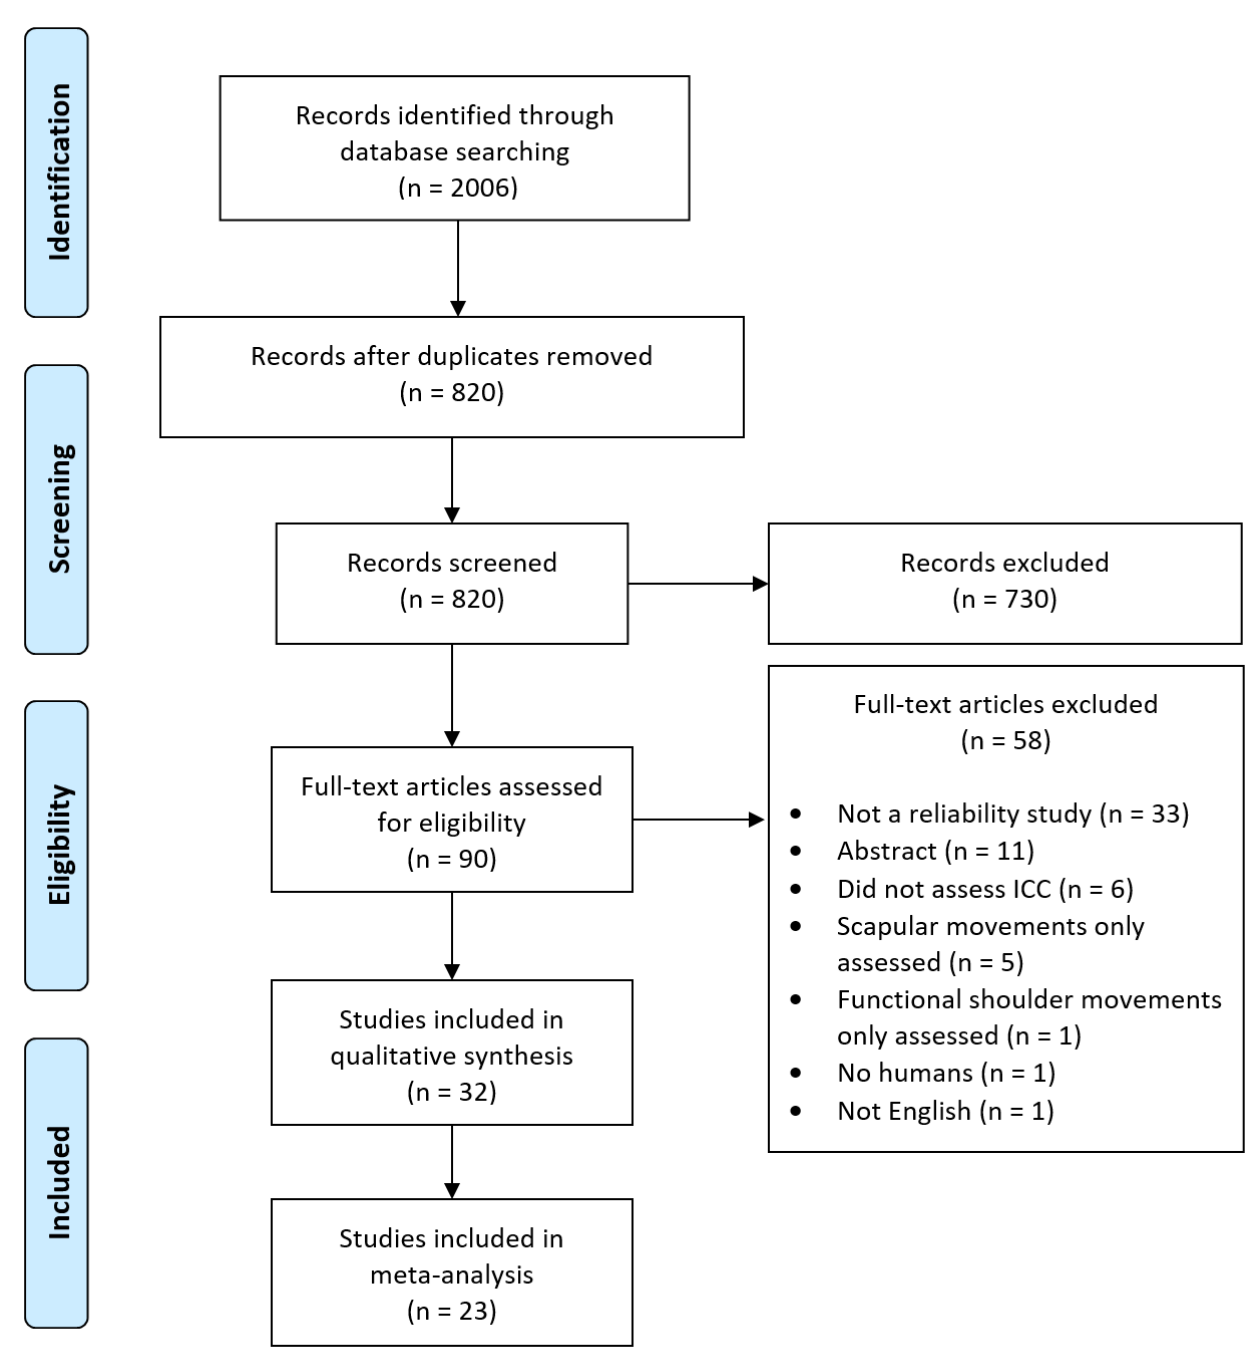
Figure 1. Flow chart of the systematic review process.